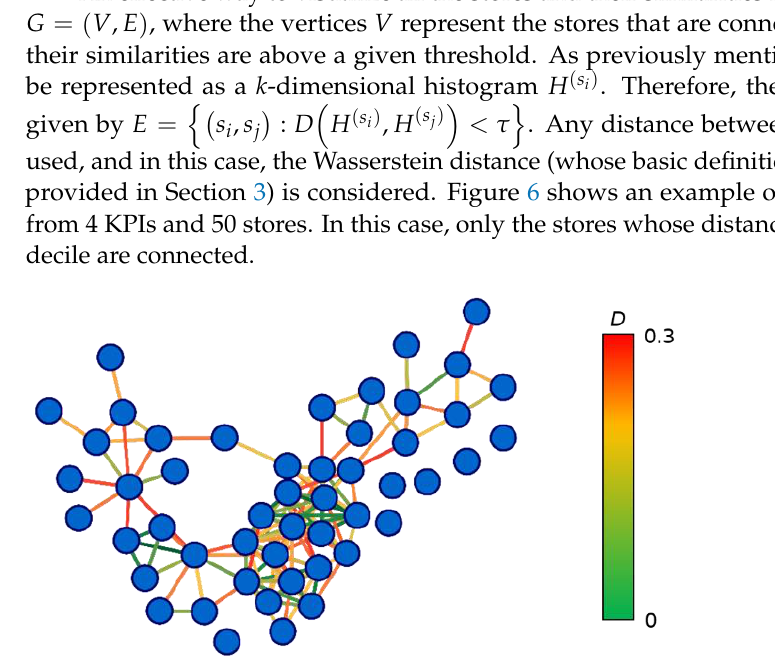
Figure 6. Graph representation of 50 stores. Edges are colored from green to red based on the distance from each other.